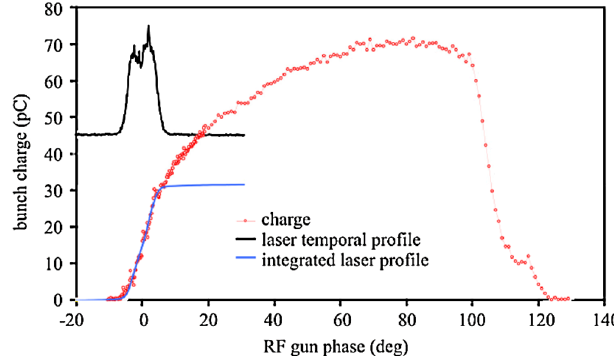
FIG. 19. (Color) Determination of the zero phase. The low- charge (70 pC maximum) phase scan is shifted to fit its left edge to the integrated laser temporal profile. Usual operation is at around 40 degrees rf-gun phase.